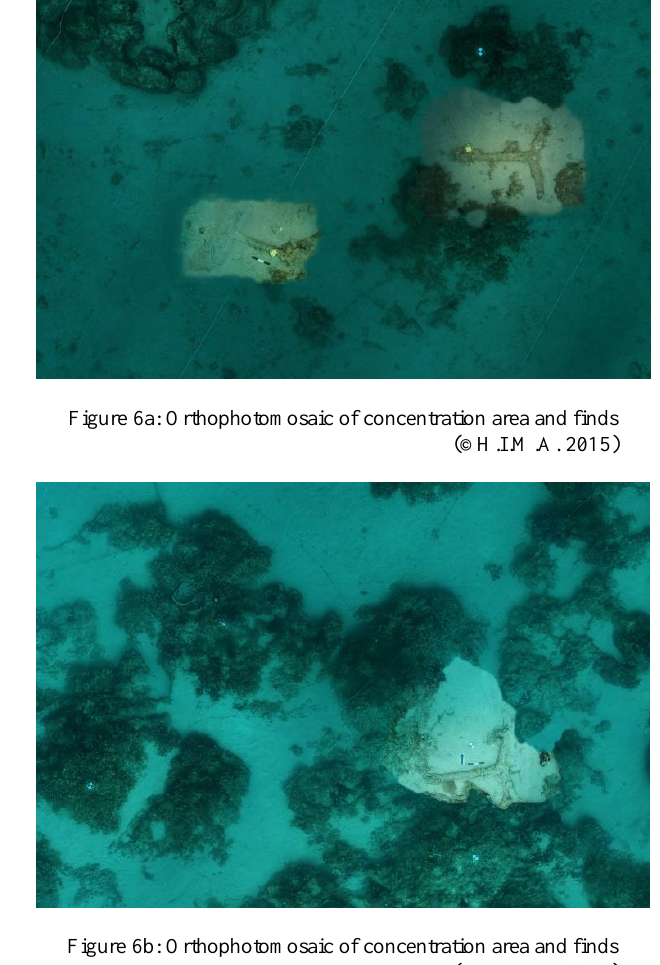
Figure 6b: Orthophotomosaic of concentration area and